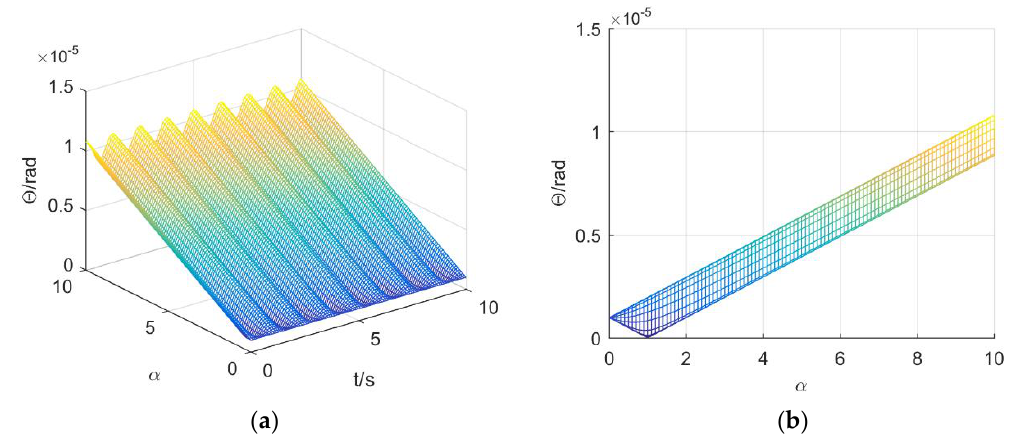
Figure 9. Given ∆ ω = 5, ∆ φ = π , the influence of amplitude ratio on the peak value of output light angle response: ( a ) The amplitude variation of output light angle response under amplitude ratio and time variables; ( b ) the relationship between the amplitude ratio and the peak value of the output light angle response. 2. Influence of excitation frequency difference on beam pointing accuracy given == ， 5 ; It can be seen from Figure 10 that the change of frequency ratio makes the peak value of rad angle response change periodically in the range of 3.9 – 5.8 , and the upper and lower limits of the peak value of angular response do not change.